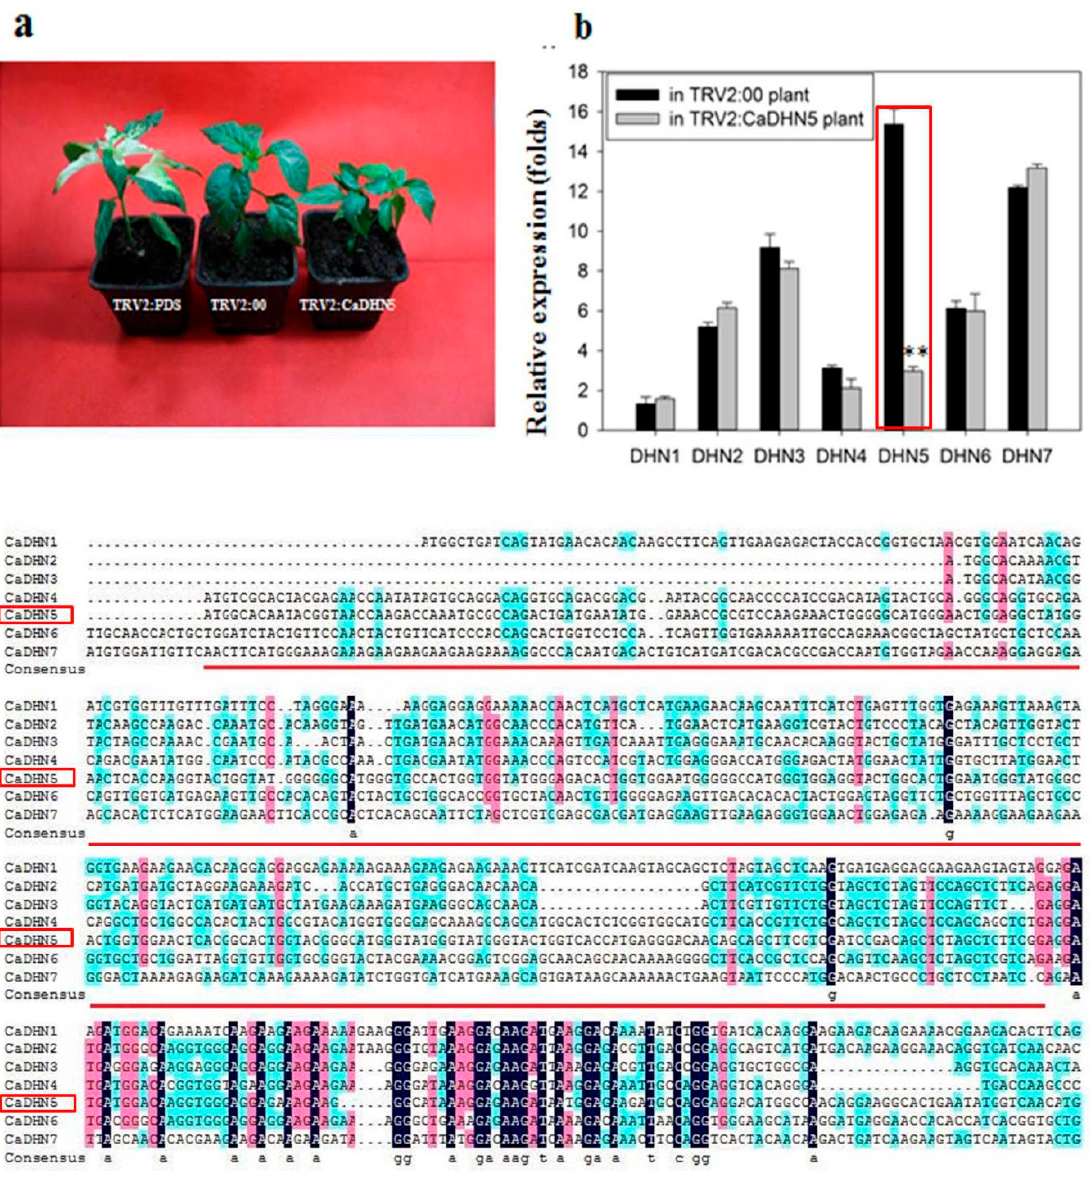
Figure 1. Phenotypes of CaDHN5 -silenced plants and detection of gene silencing efficiency. ( a ) The phenotypes of silenced pepper plants (about four weeks after injection); ( b ) The relative expression of CaDHN5 in silenced pepper plants and silencing sequence analysis of CaDHN5 . The red frame is expression of CaDHN5 in silenced and control plants. The black areas represent homology level 100%. The pink areas represent a level of homology greater than or equal to 75%. The blue areas represent a level of homology greater than or equal to 50%. The underlined part is a sequence of silencing. The results are the means ± standard deviation (S.D.), replicated three times. The means were compared using Student’s test. Note: * indicates significant differences compared with the control at p < 0.01.